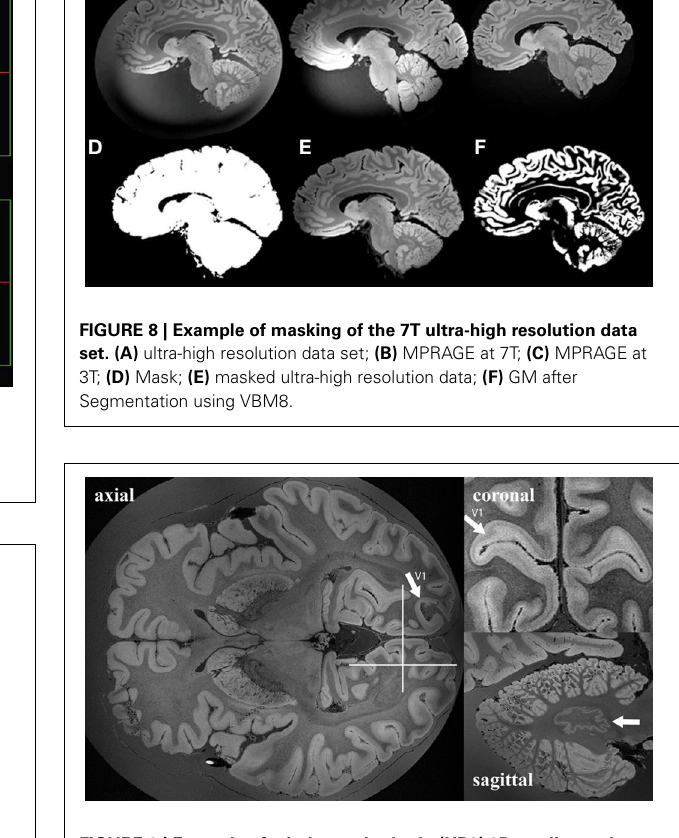
FIGURE 9 | Example of whole ex vivo brain (HB2) 3D gradient echo T2 ∗ -weighted imaging with 150 µ m isotropic resolution. White arrows in the axial and coronal views point to the primary visual cortex. White arrows in the sagittal view point to nucleus dentatus of the cerebellum. White lines in the axial view on the right show the anatomical locations of the coronal and the sagittal views on the